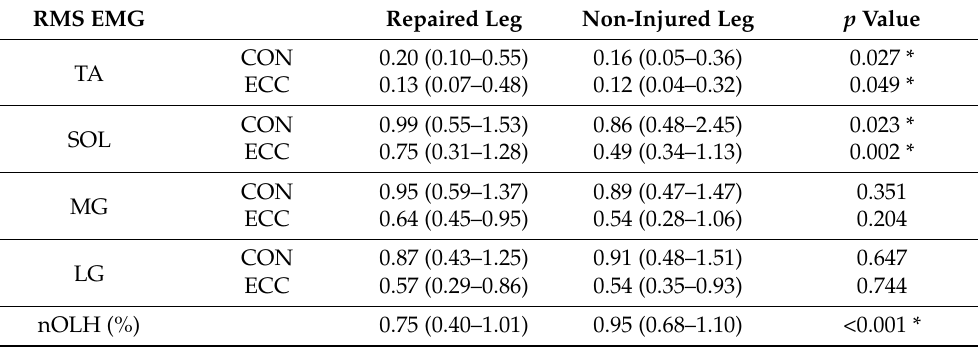
Table 2. Results of normalized RMS EMG data during the concentric and eccentric phases of the one-legged heel-raise exercise, and normalized hopping